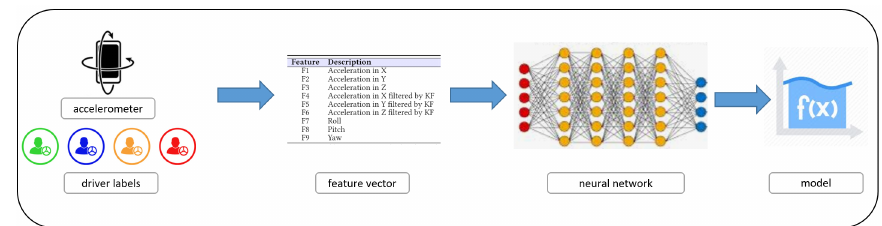
Figure 5. The Training step.